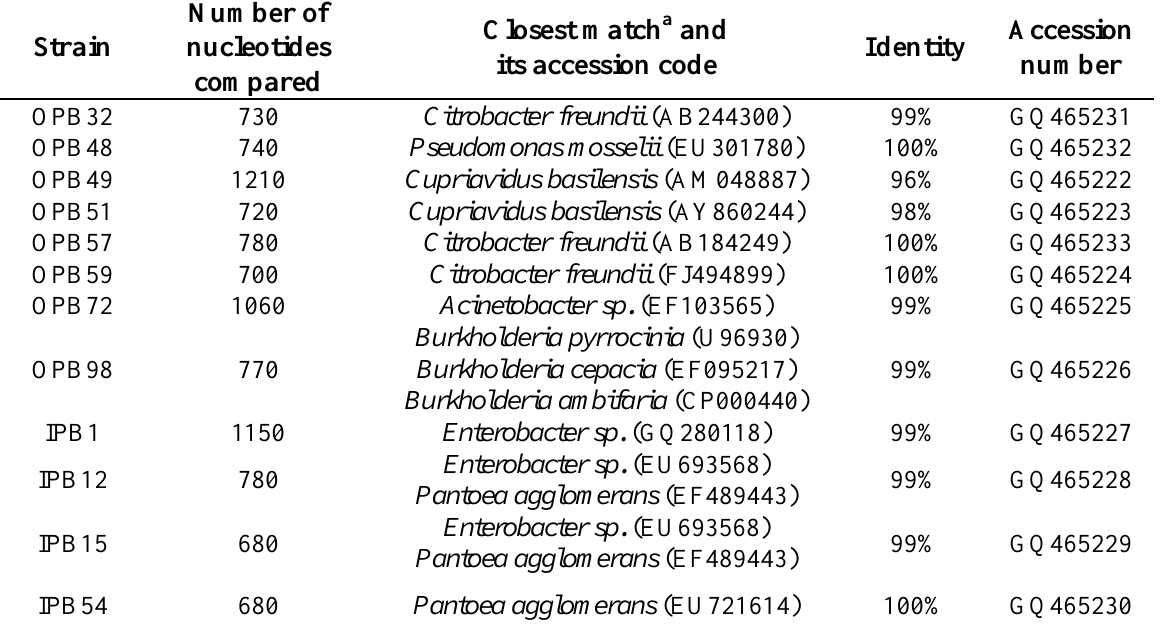
Table 1. Identification of predominant OPB and IPB strains by alignment with 16S rDNA sequences of organisms in the NCBI database.